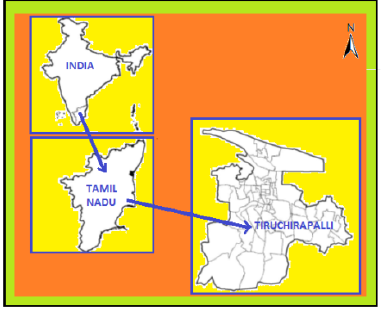
Figure 1: Location Map of Tiruchirappalli